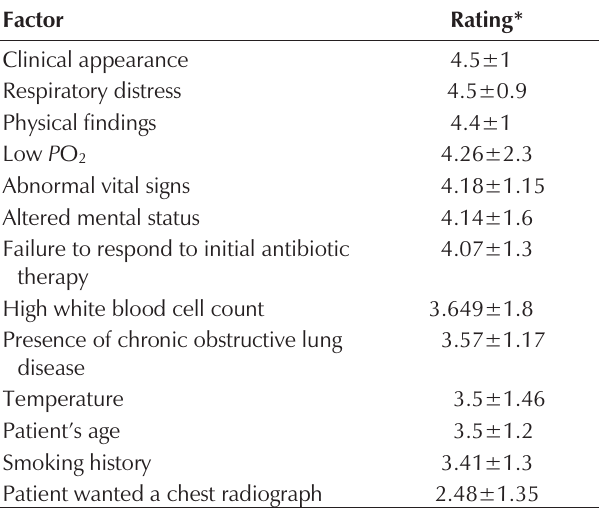
Response to skill-testing question 2 from survey Question: A 22-year-old female nonsmoker with right upper lobe pneumonia responds promptly to your treatment.